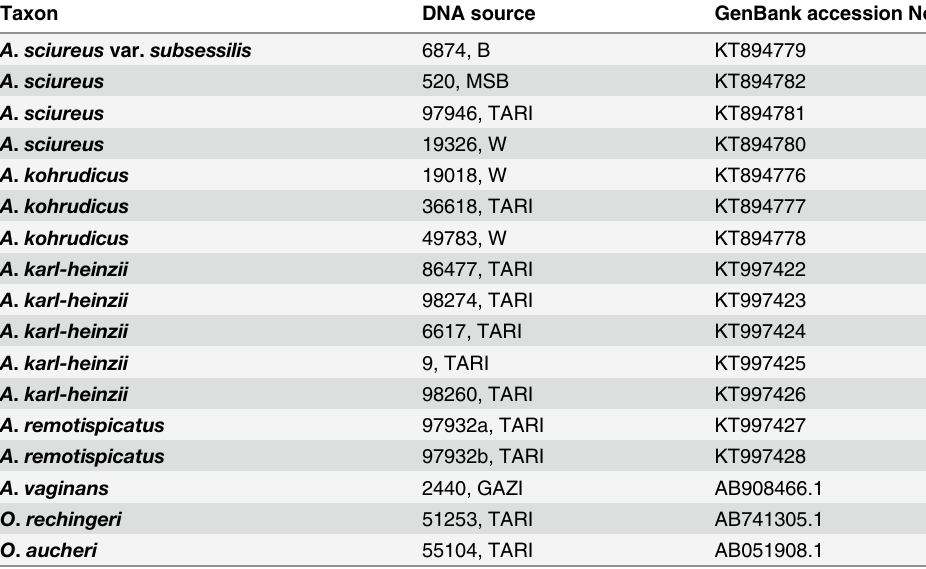
Table 2. Information of examined taxa in molecular study. Taxon DNA source GenBank accession